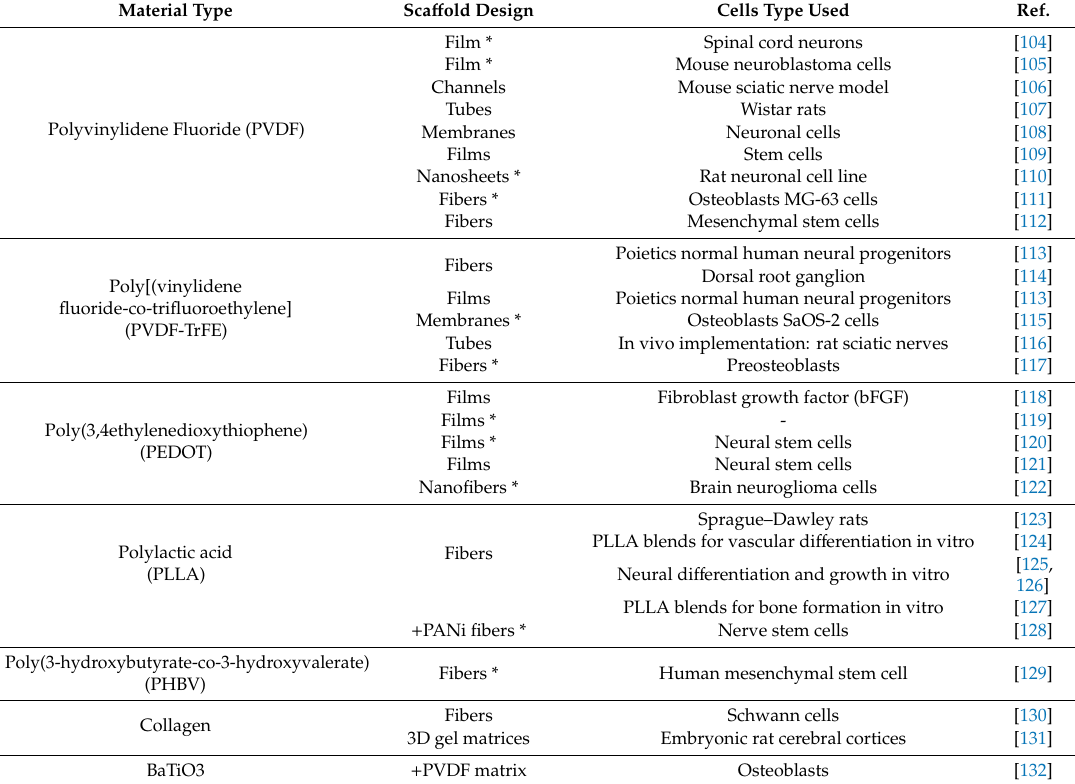
Table 2. Piezoelectric materials in nerve tissue